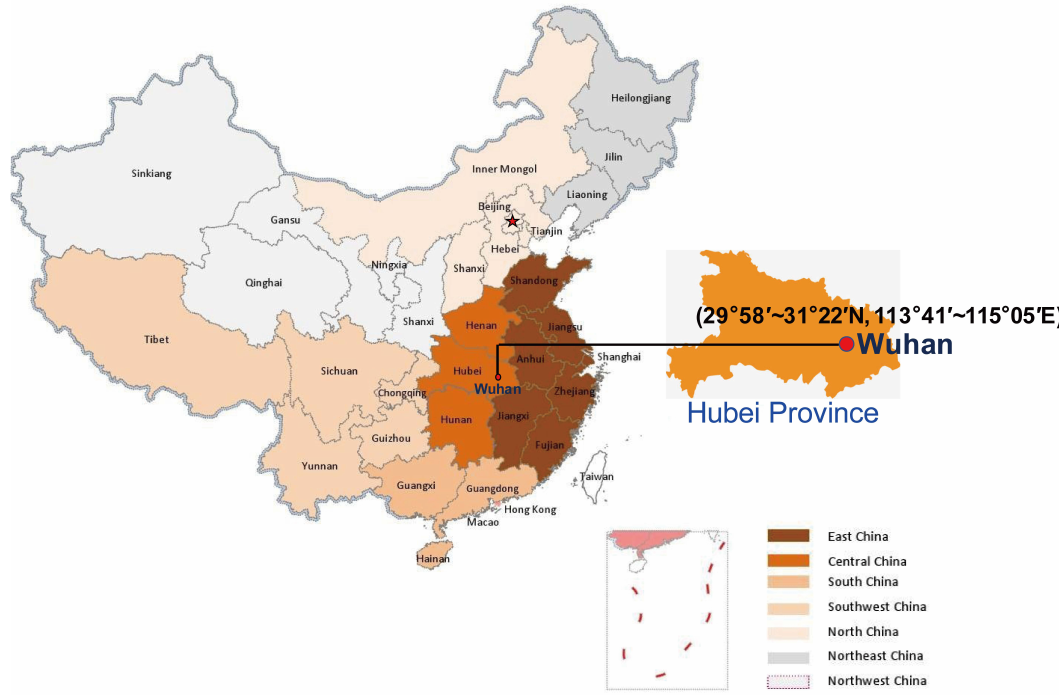
Figure 1. Geographic location of Wuhan, Hubei Province in China. Hubei Province is located in the central area of China, and the provincial capital is